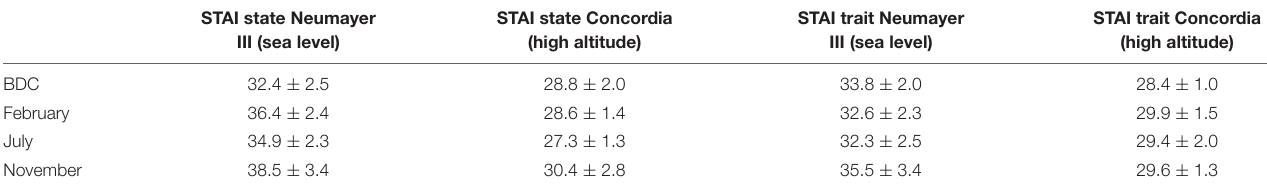
TABLE 4 | Psychometric data of STAI.